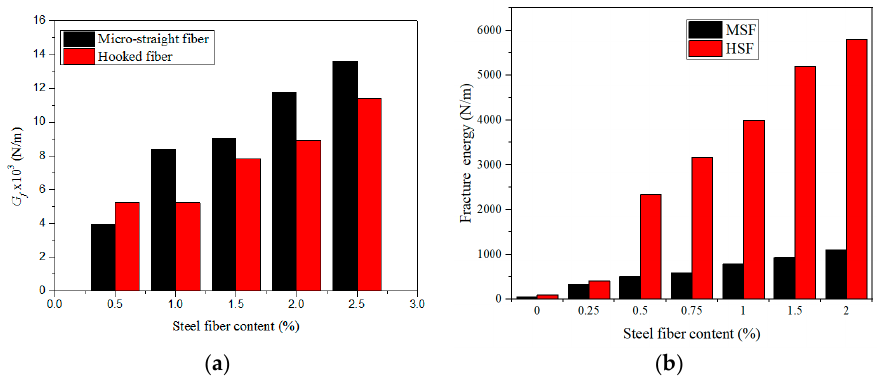
Figure 19. Effects of the SF fiber type and content on f G [84,89 ]. ( a ) Ratio of water to cementitious materials: 0.16, ( b ) water–binder ratio: 0.195.